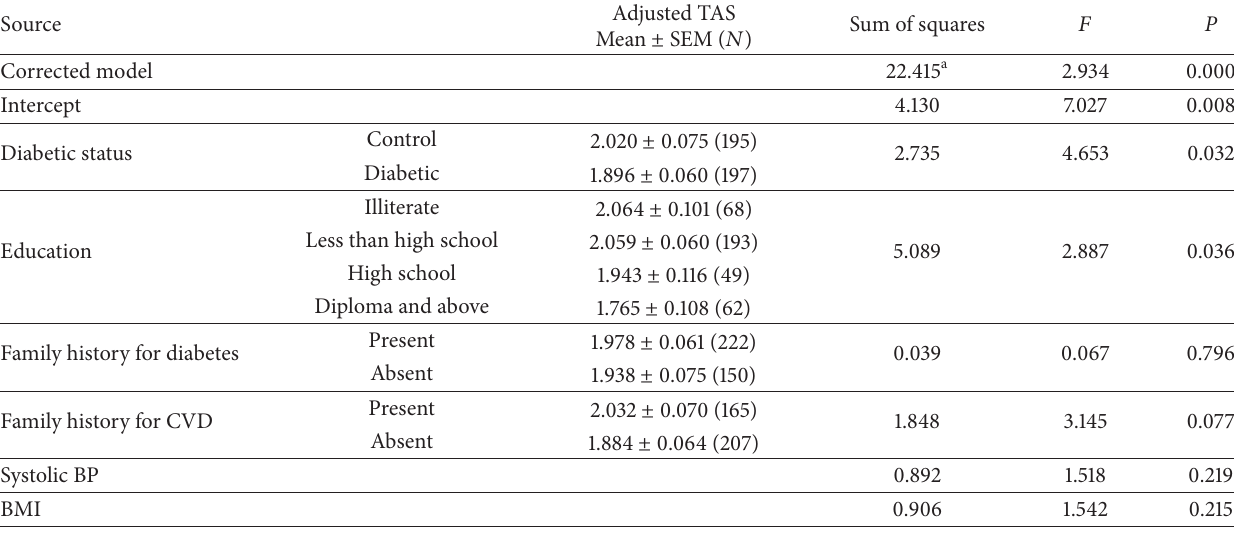
Table 4: Results of multivariate analysis for predictors of the TAS